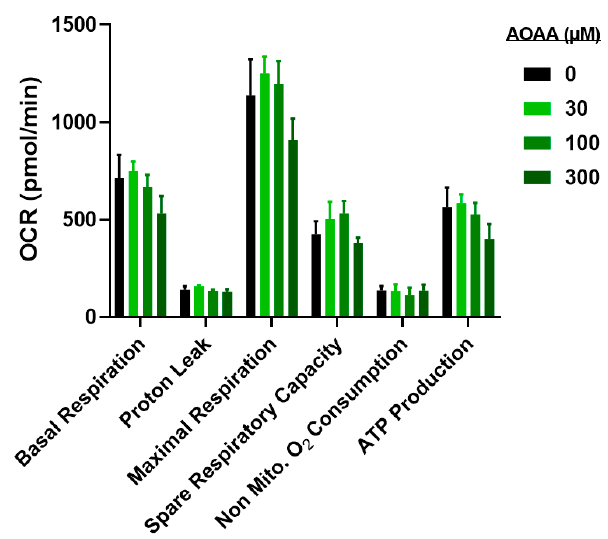
Figure 12. Effect of AOAA on bioenergetics parameters and cell viability in CT26 cells: Analysis of oxidative phosphorylation-related bioenergetics parameters. Results are indicated as mean ± SEM of three independent replicates per condition and corresponding Dunnett’s multiple comparisons tests vs. 0 µM of each parameter respectively are not significant.